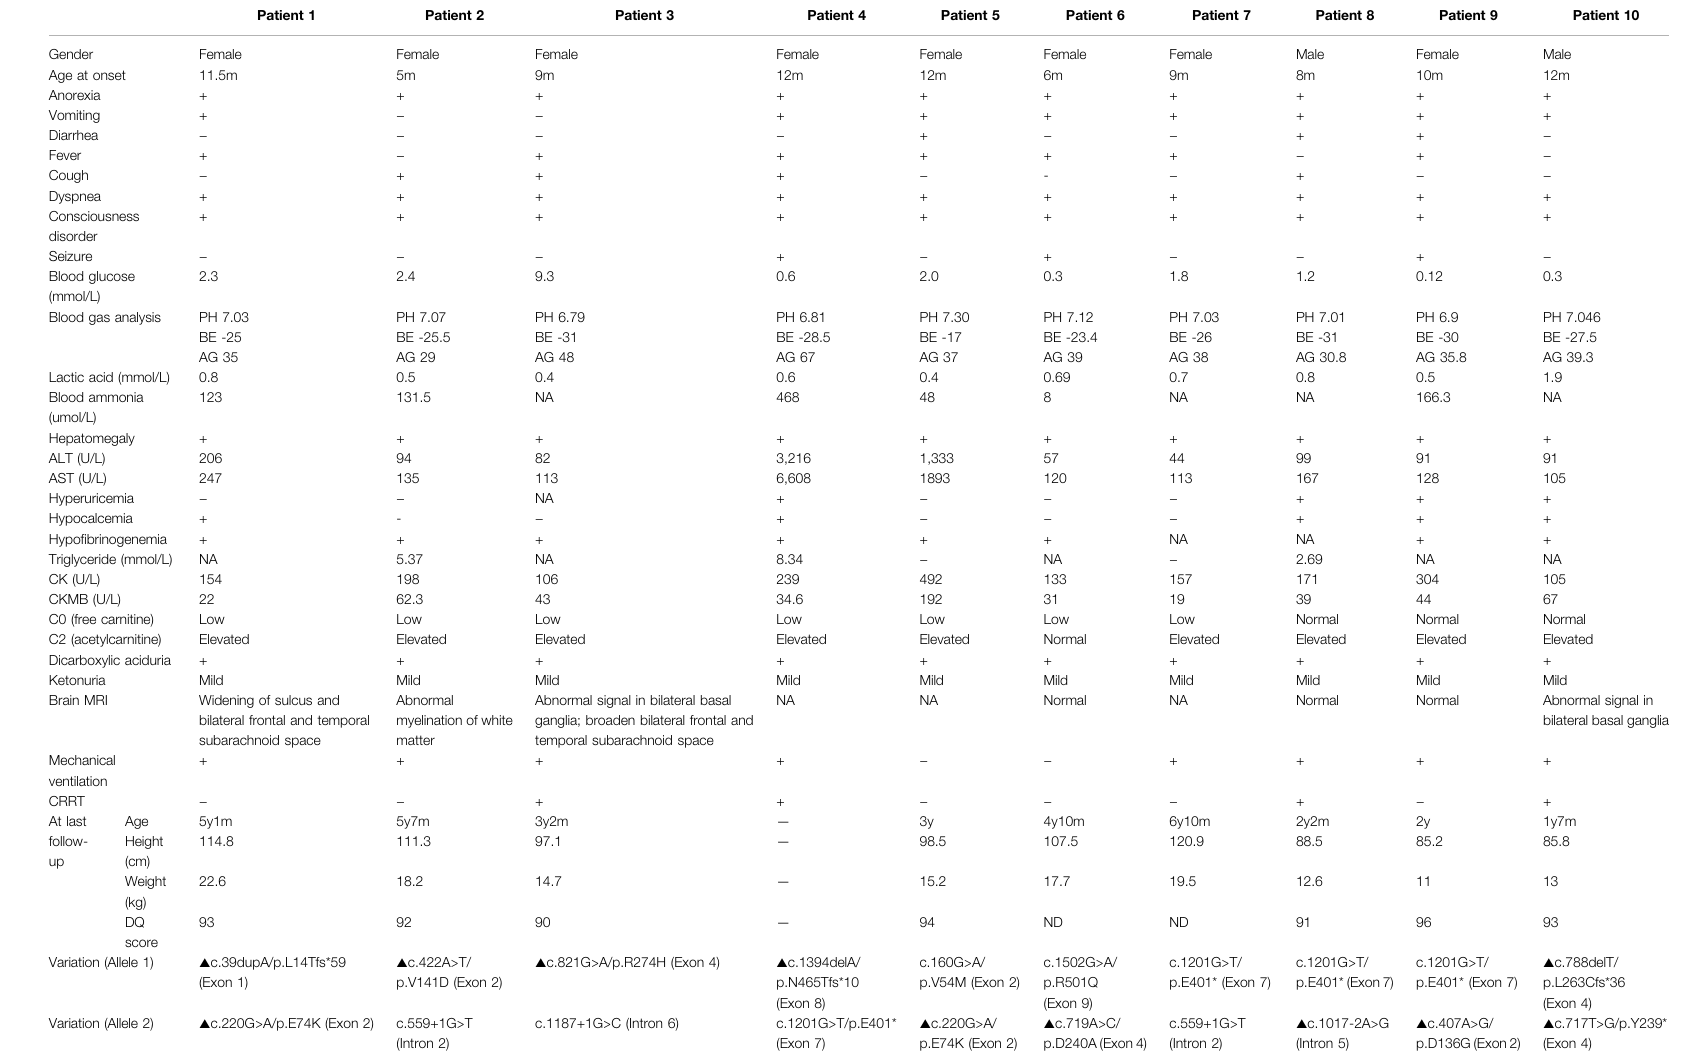
TABLE 1 | Clinical information, biochemical assays, and outcome fi ndings of 10 new patients with HMGCS2D.